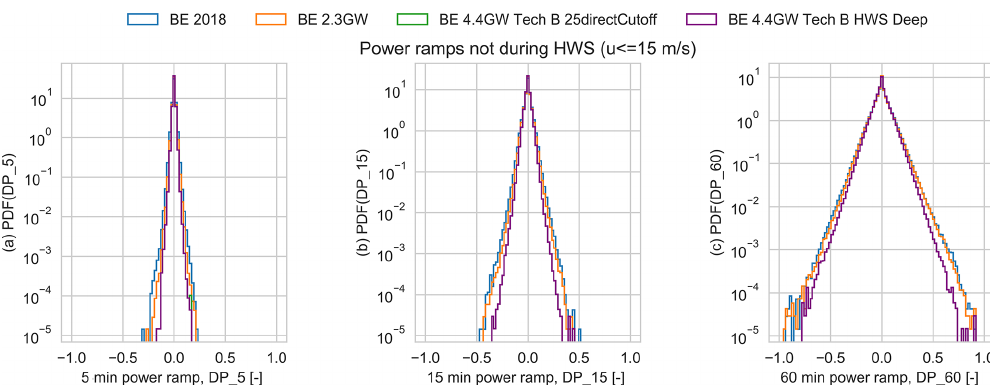
Figure 11. Distributions of standardized power fluctuations during low wind speeds in all the scenarios in different time windows: (a) 5min (DP_5), (b) 15min (DP_15), and (c) 1h (DP_60). The curves for the BE 4.4GW Tech B scenarios are on top of each other, with only a small difference in the left figure at around DP_5 = 0.2. Tech A is omitted for clarity because it behaves very similar to Tech B.